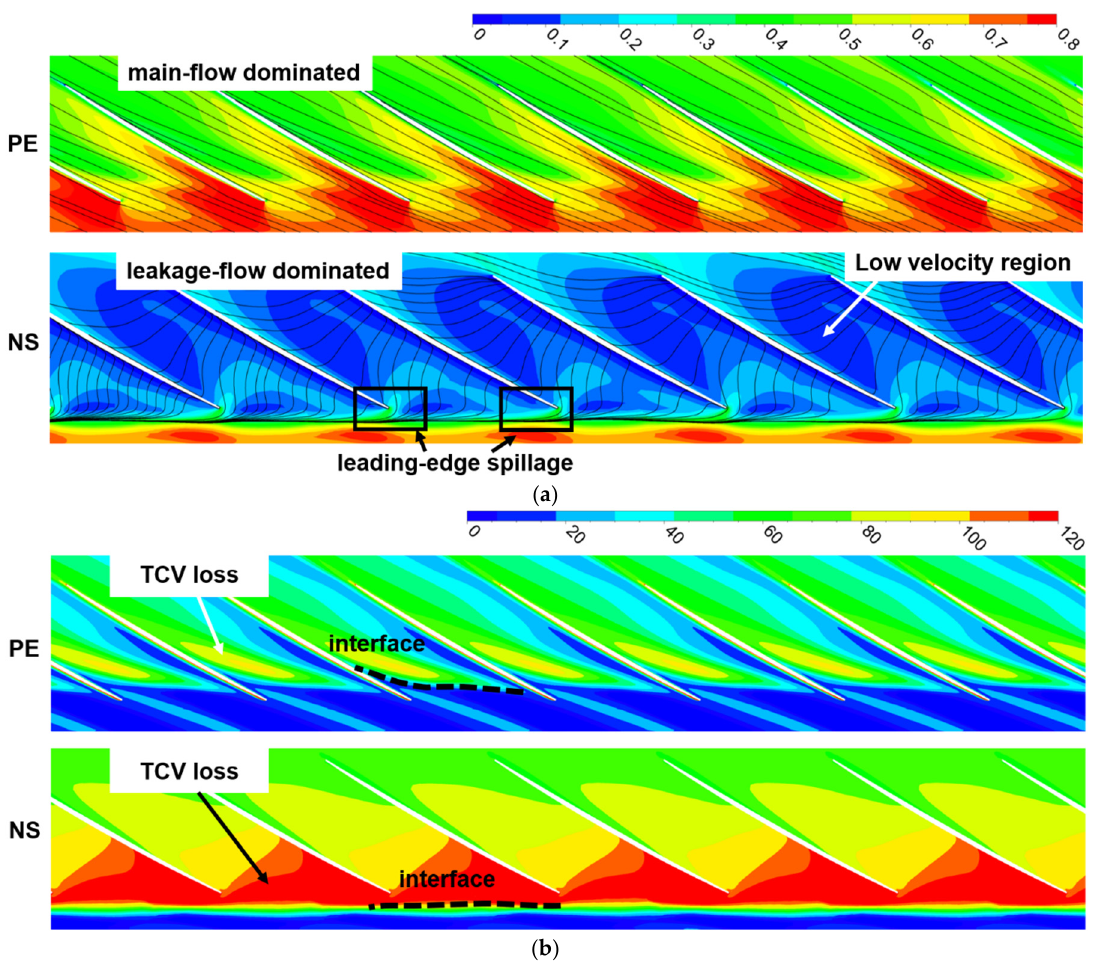
Figure 15. Time-averaged results at 96% of span. ( a ): Relative Mach contours with streamline of relative velocity. ( b ): Entropy contours (J/(kg K)).